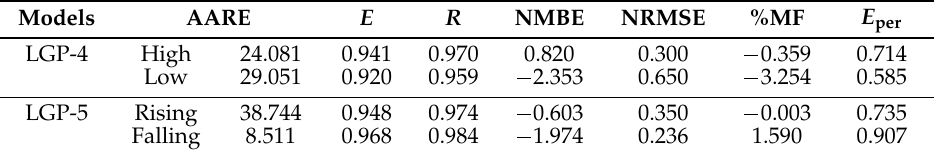
Table 6. Statistical measures for validation dataset of High/Low flow seasons and Rising/Falling portions of